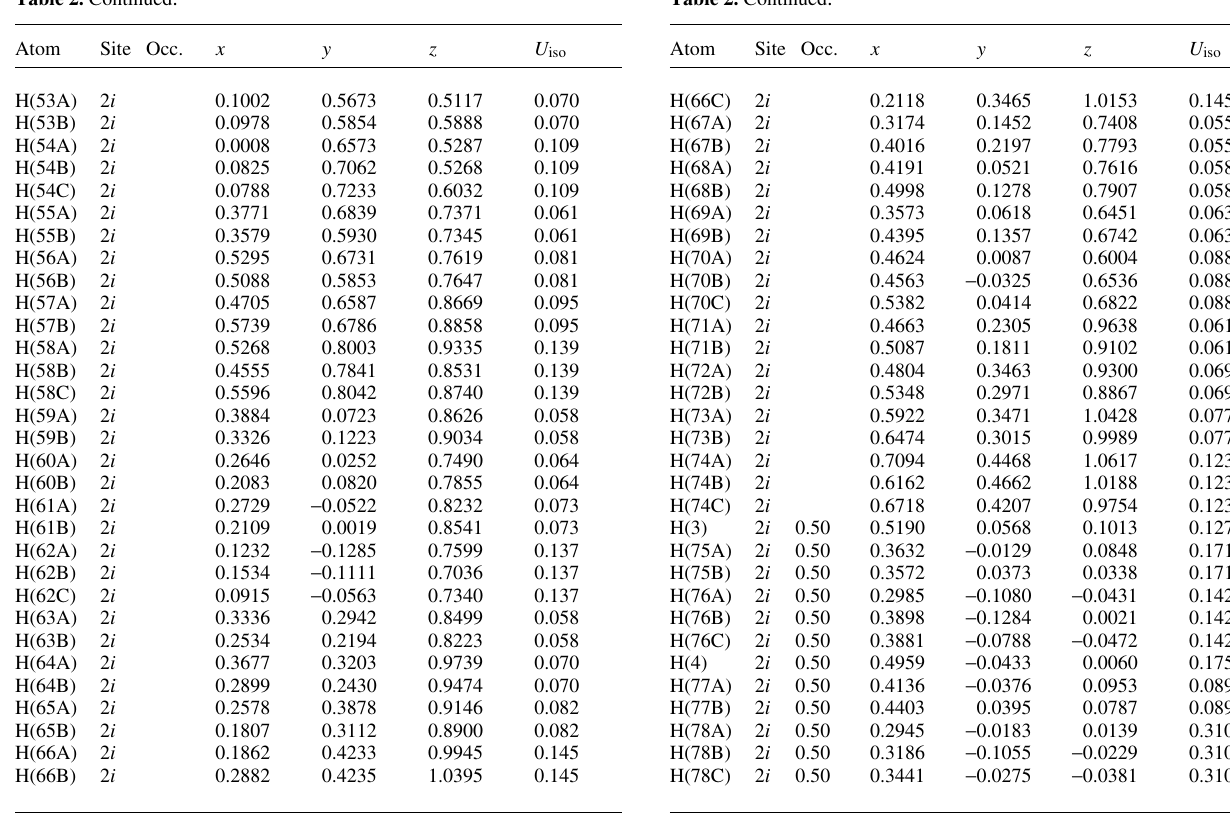
Table 3. Atomic coordinates and displacement parameters (in Å 2 ) . Atom Site